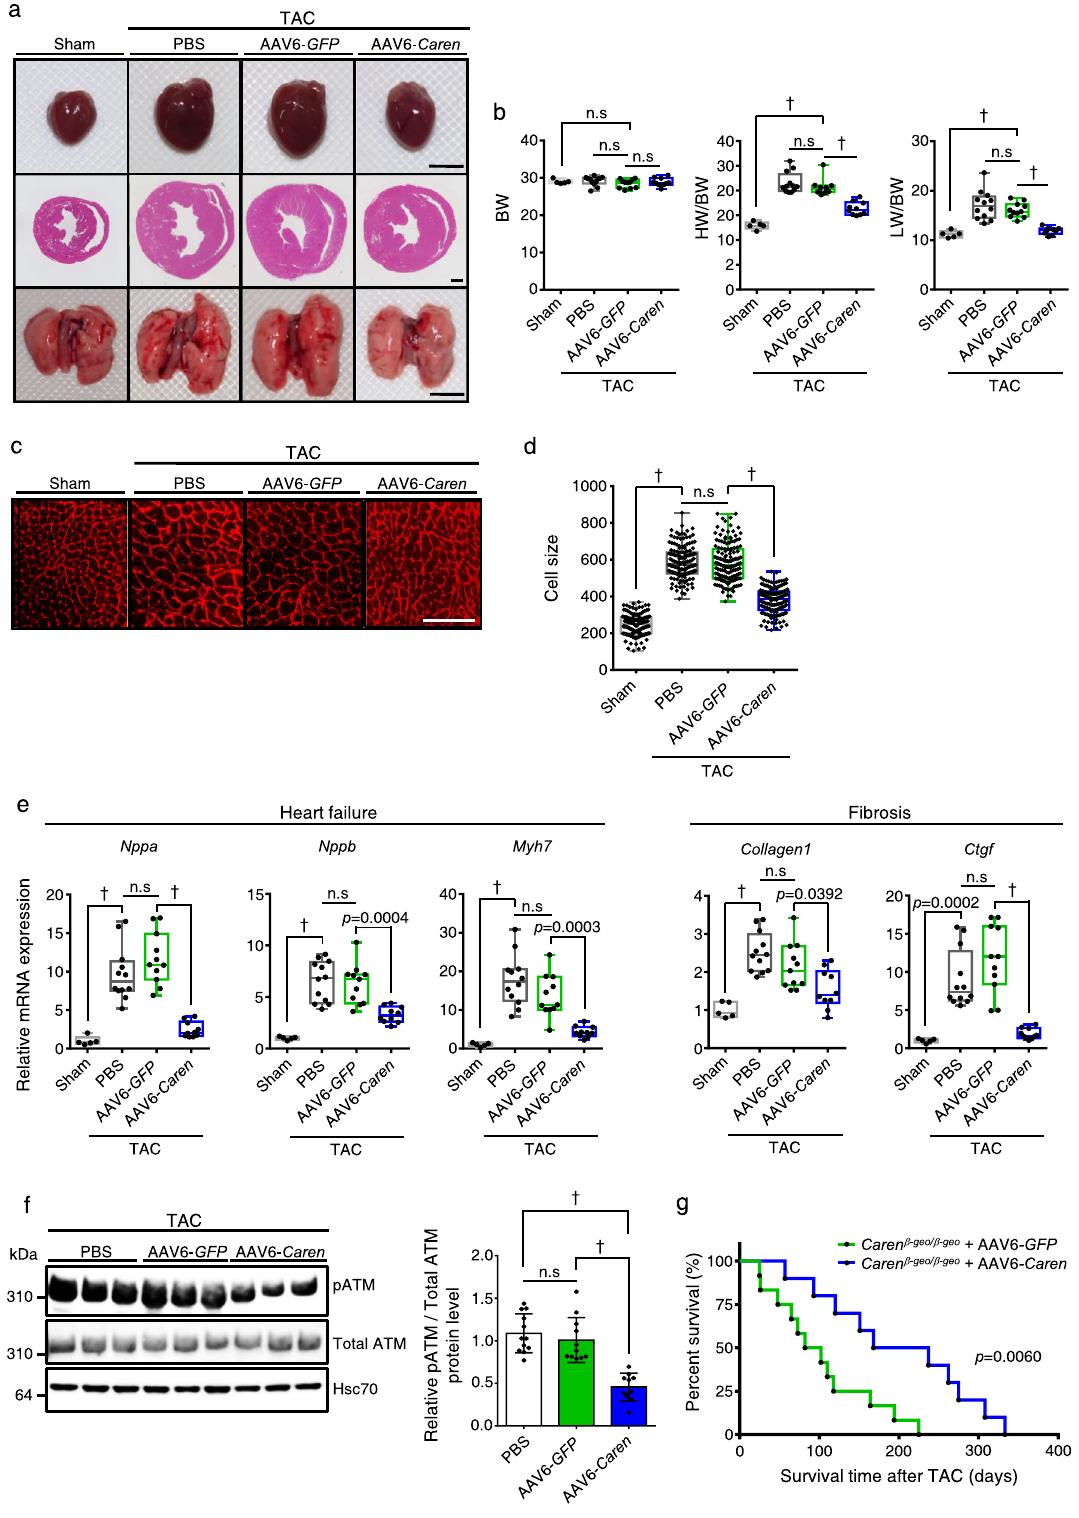
Supernatants were incubated with streptavidin magnetic beads (MyONE Streptavidin C1 magnetic beads, Thermo Fisher Scienti fi c Inc.) for 20 min at 37 °C. After incubation, streptavidin-cleared samples were collected and incubated with 100 pmol of 5 ’ -biotinylated antisense single-strand DNA (ssDNA) probes against Hint1 or LacZ (a negative control) mRNA (Supplementary Table 5) for 3 h at 37 °C. After hybridization, samples were incubated with streptavidin magnetic beads for 30min at 37°C and washed 6 times in wash buffer (20 mM Tris-HCl, 10 mM EDTA, 1% NP-40, 0.2% N-lauroylsarcosine, 0.1% sodium deoxycholate, 3